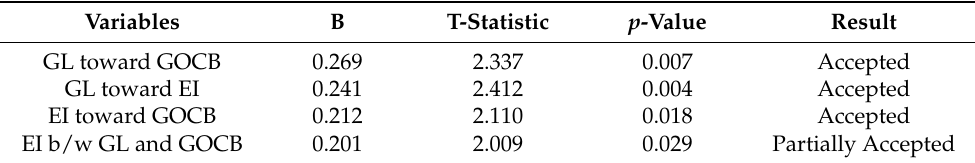
Table 5. PC, TS, PV, R 2 .